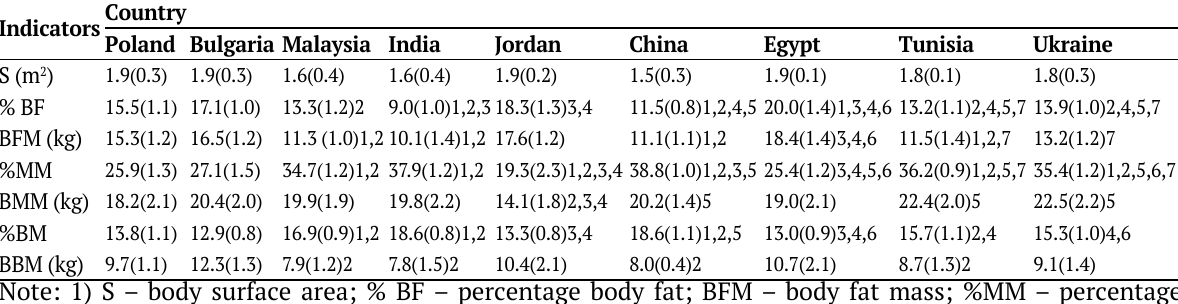
Table 5. Values of indexes % BF, BFM, %MM, BMM, %BM, BBM of students Country Indicators Poland Bulgaria Malaysia India